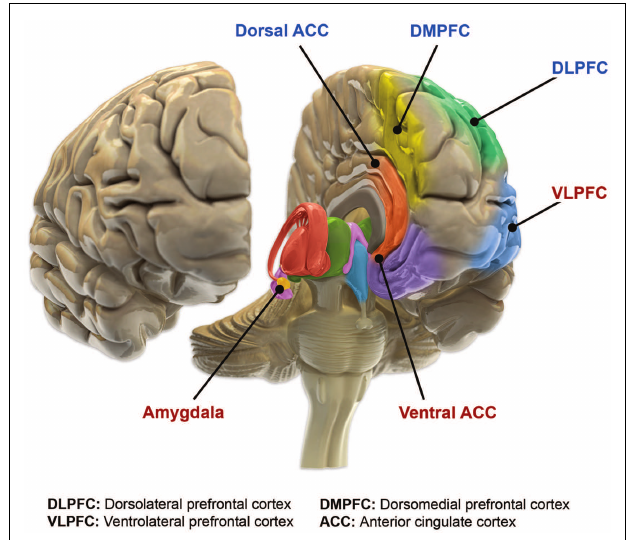
FIGURE 2 | Functional brain changes in bipolar disorder. Based on Langan and McDonald (91). Illustration courtesy of: RolandTuley, Fire and Rain. Imaging studies of euthymic bipolar patients provide evidence of compromised cognitive control, combined with increased responsiveness of limbic and para-limbic brain regions involved in emotional regulation. Brain areas associated with cognitive control, which manifest reduced responsiveness, are labeled blue (dorsal ACC, DMPFC, and DLPFC). By contrast, limbic and para-limbic brain areas involved in emotional regulation, associated with greater responsiveness, are labeled in red (amygdala, VLPFC, and ventral ACC).